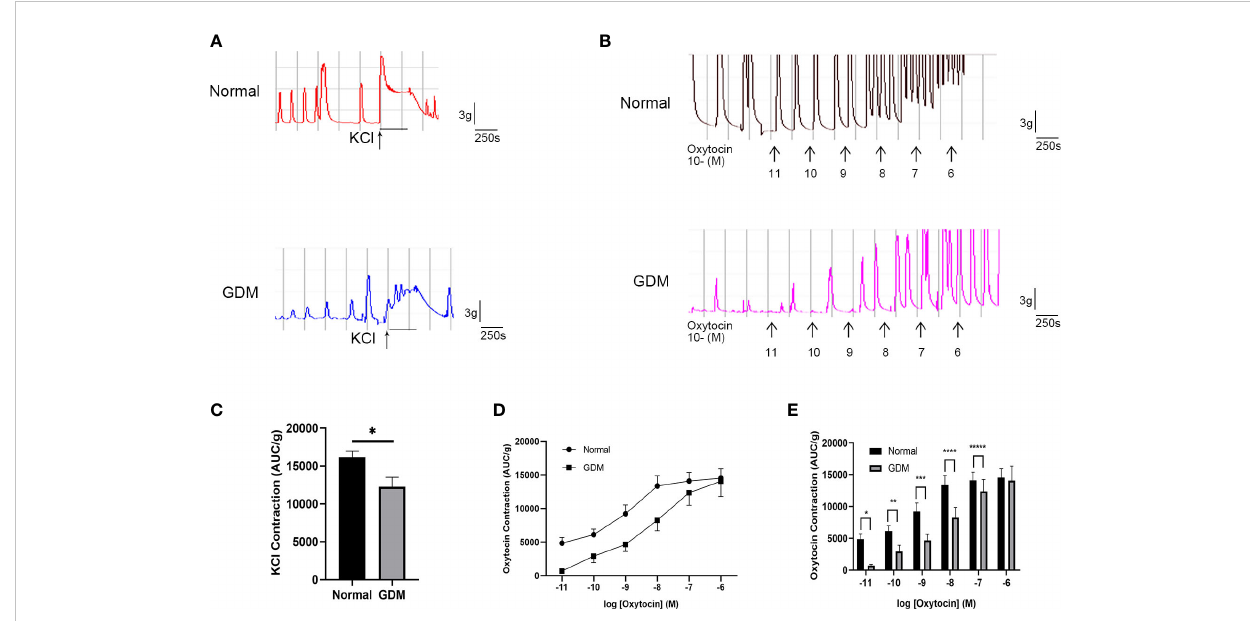
FIGURE 1 Decreased uterine contractility in patients with GDM. Uterine strips from normal (Nor) individuals and patients with GDM were stimulated with 96 mM KCl (A) followed by washing 3 times in Krebs solution and then stimulated with increasing concentrations (10 -11 to 10 -6 M) of oxytocin (B) . The contraction to KCl (C) and oxytocin (D, E) was measured as AUC/g tissue. Data are presented as means ± SEM, n = 6 to 7. * to ***** mean GDM vs. Nor and P<0.05. AUC, area under the curve; GDM, gestational diabetes mellitus; SEM, standard error of the